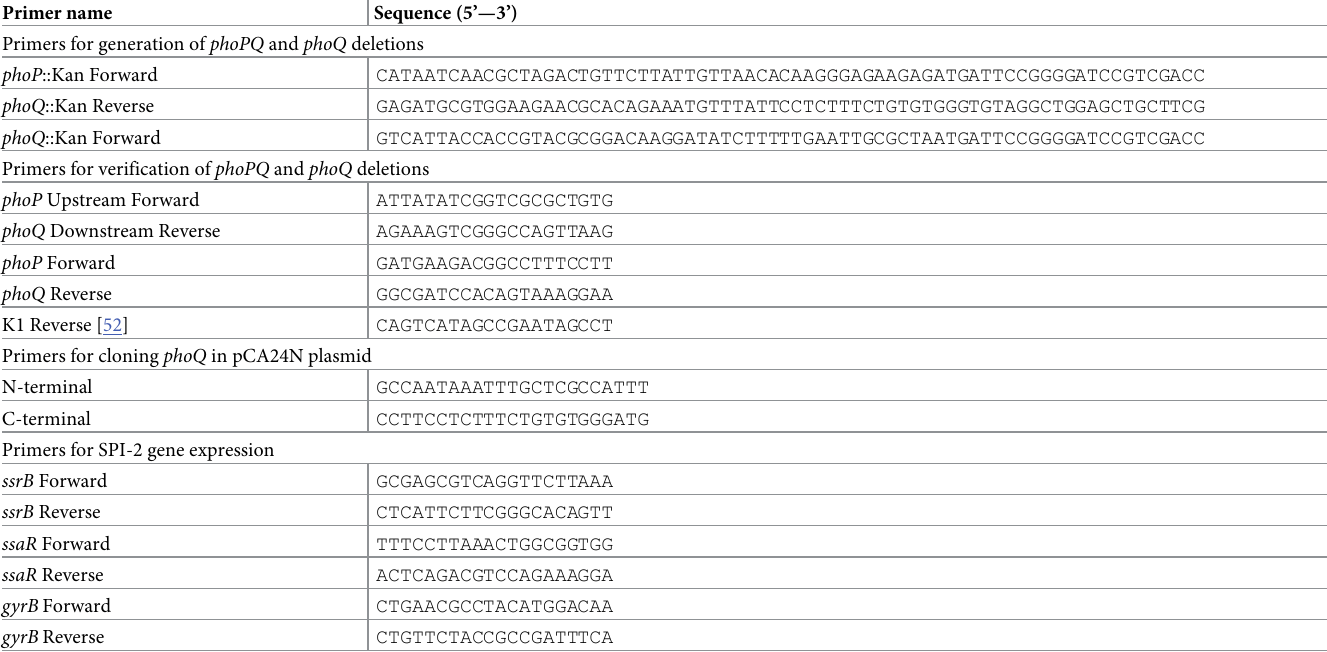
Table 1. Primers used in this